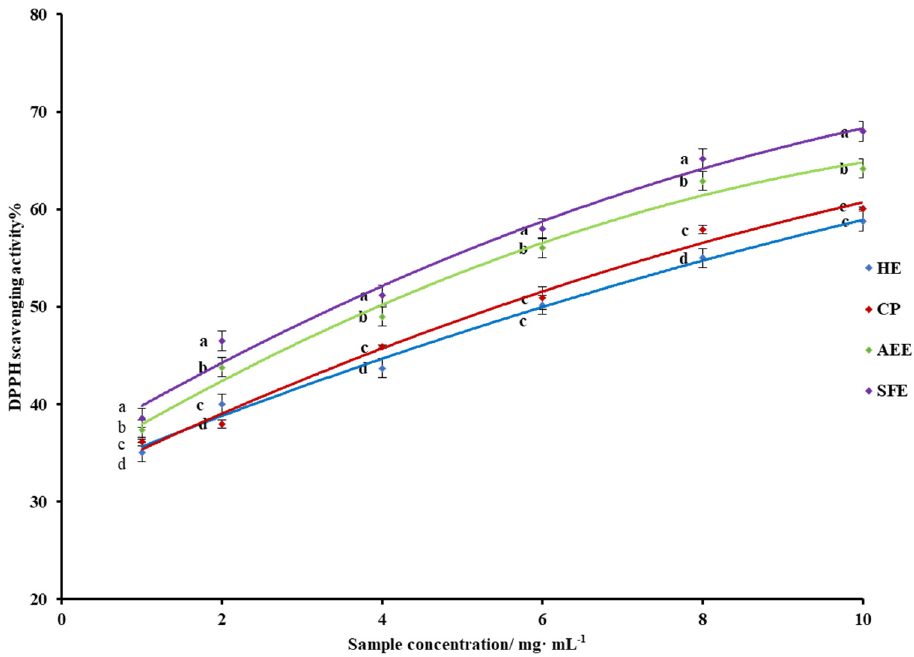
Figure 1. The DPPH radical-scavenging ability assay of X. sorbifolia oil. Means with different letters in the same column are significantly different.